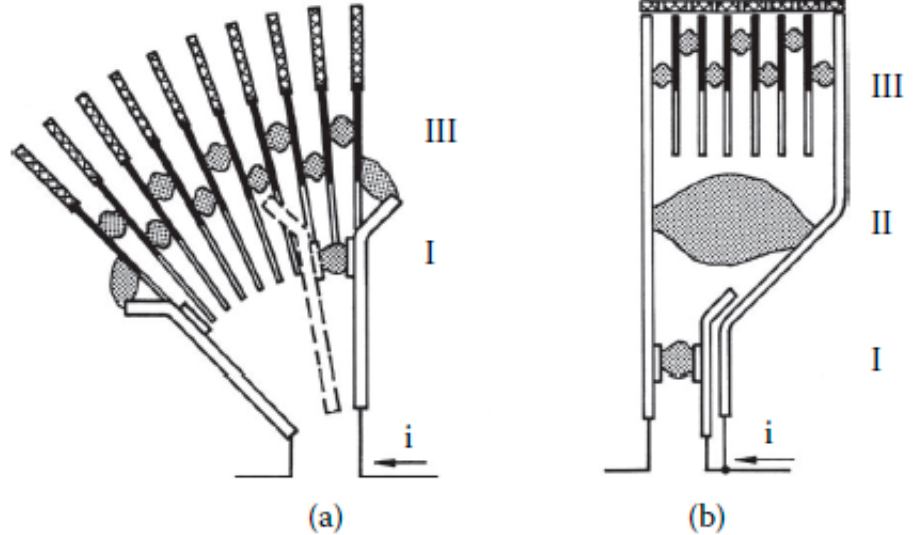
Figure 7. Schematic circuit breaker arrangements: ( a ) without commutation to a stationary arc runner; ( b ) with commutation to arc runner connected with the moving contact. I—arc between contacts; II—arc in intermediate position; III—arc split up between de-ion plates [2].